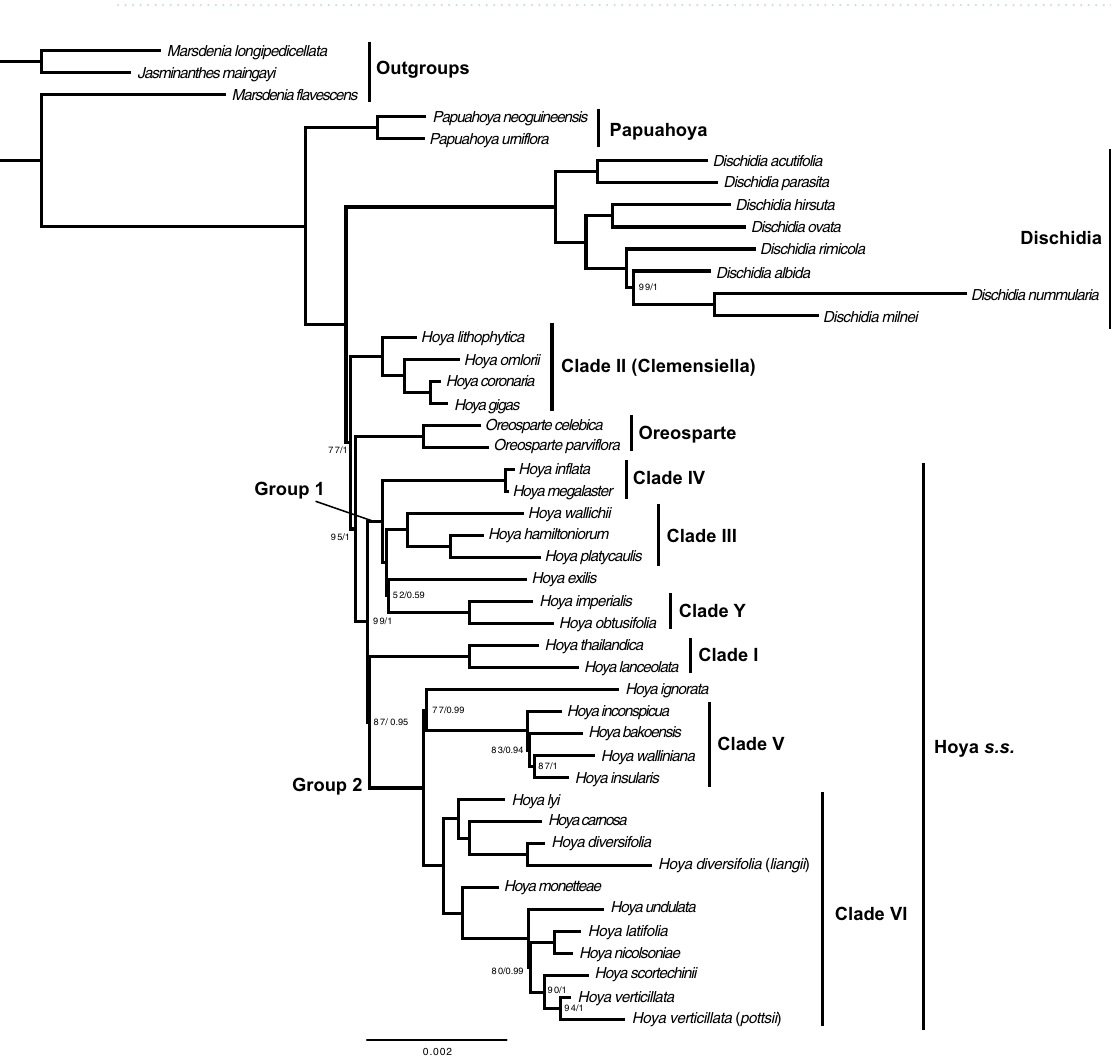
Figure 6. Molecular phylogeny of representative species of the Hoya group based on exons longer than 90 bp (excluding accD , ycf1 and ycf2 ). Numbers at the nodes indicate bootstrap percentages followed by Bayesian Posterior Probability (only indicated when not fully